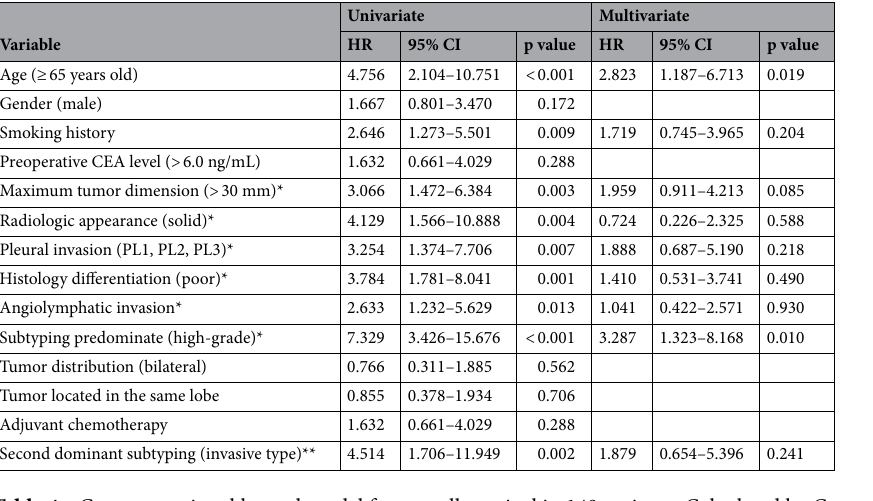
Table 4. Cox proportional hazard model for overall survival in 149 patients. Calculated by Cox regression method. CEA Carcinoembryonic antigen. *Dominant tumor. **Second dominant tumor with other than lepidic predominant